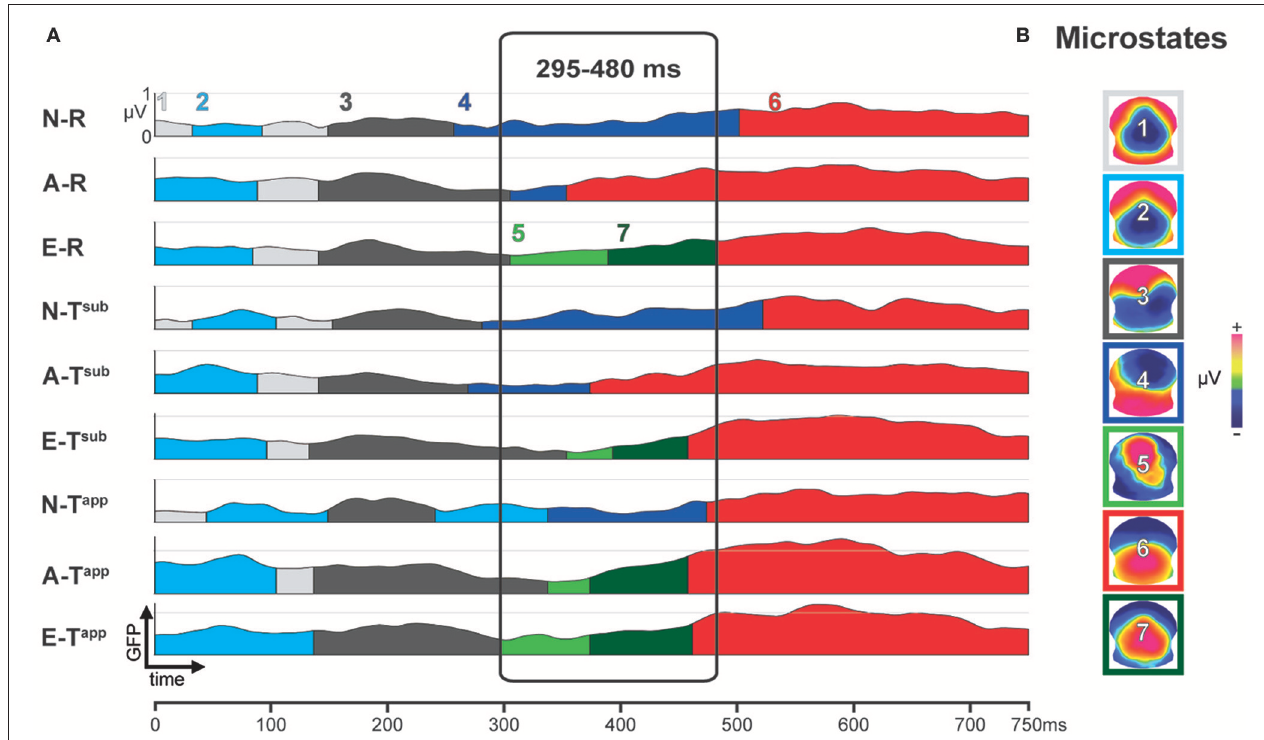
FIGURE 4 | Results of spatio-temporal ERP analysis: functional microstates. (A) Color-coded segments below the GFP curve represent the periods of strongest occurrence of the microstates (1–7) in the grand means. (B) Scalp potential topographies of ERP microstates, framed in corresponding color-code. N-R, Non-musicians, Regular Endings; A-R, Amateurs, Regular Endings; E-R, Experts, Regular Endings; N-T sub , Non-musicians, Subtly Transgressed Endings; A-T sub , Amateurs, Subtly Transgressed Endings; E-T sub , Experts, Subtly Transgressed Endings; N-T app , Non-musicians, Apparently Transgressed Endings; A-T app ,